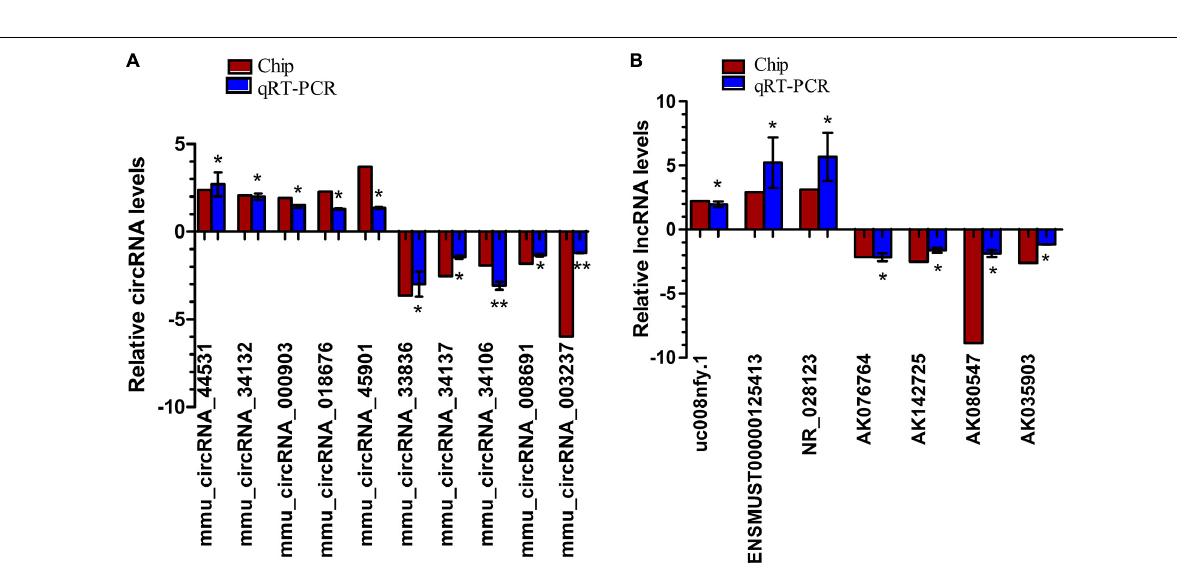
Frontiers in Molecular Neuroscience |